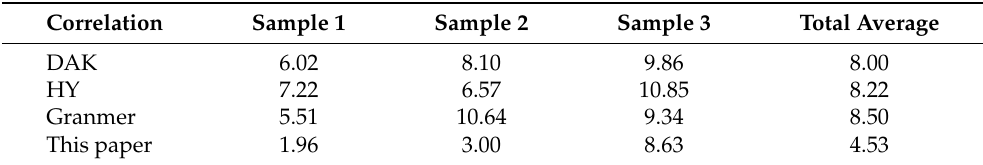
Table 2. The absolute average error of the compressibility factors computed by the four empirical methods compared with measured results.